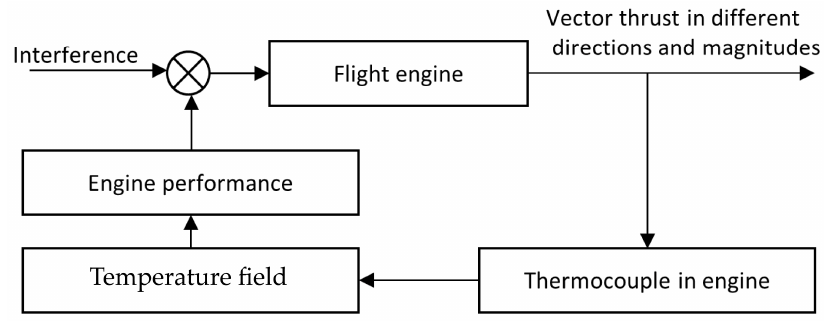
Figure 1. Thermocouple in aeroengines’ thrust control